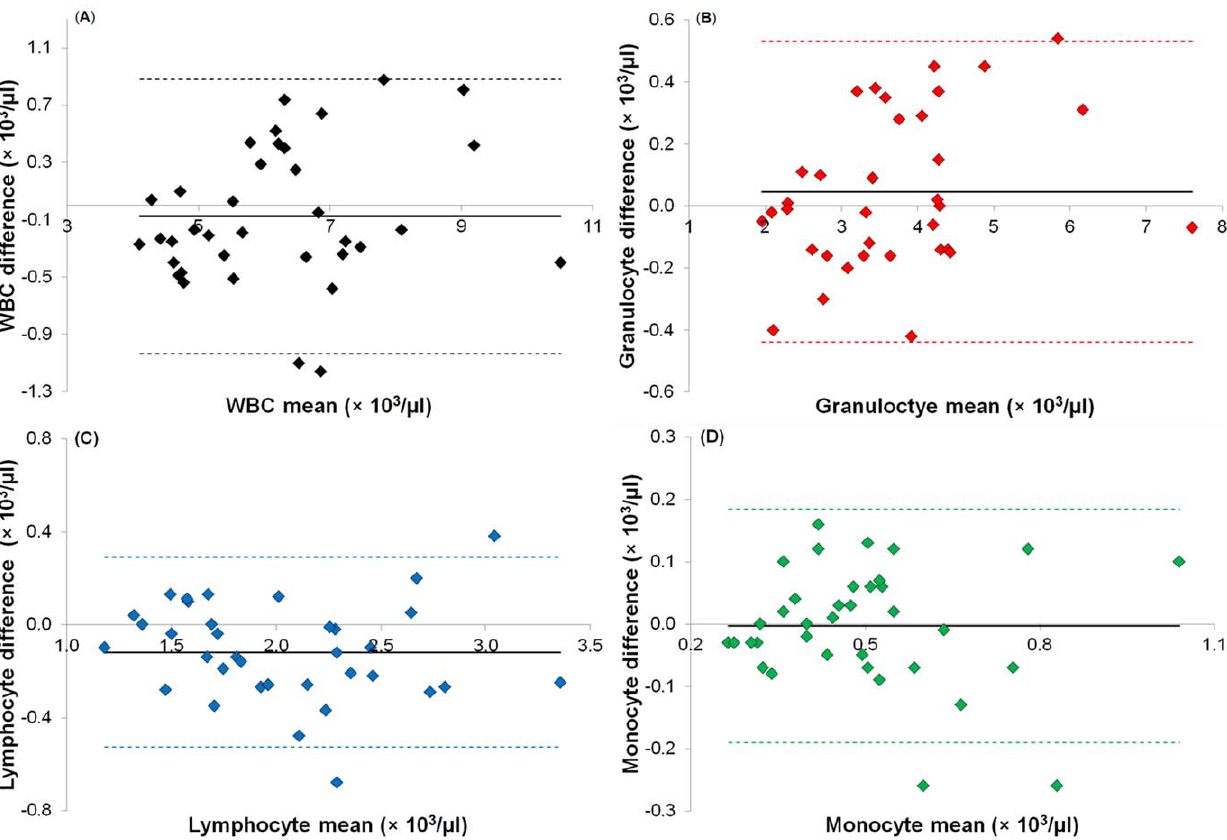
Figure 3. Bland-Altman analysis of venous/fingerprick concordance. Bland-Altman plots showing mean of against difference between venous and fingerprick blood samples for (A) Total WBC (B) Granulocyte (C) Lymphocyte and (D) Monocyte concentrations measured using the Sysmex XE-2100 (n=36). Thick black line shows bias (average difference) between venous and fingerprick, dashed (colored) lines show the 95% limits of agreement (LOA), (average difference 6 1.96 SD).